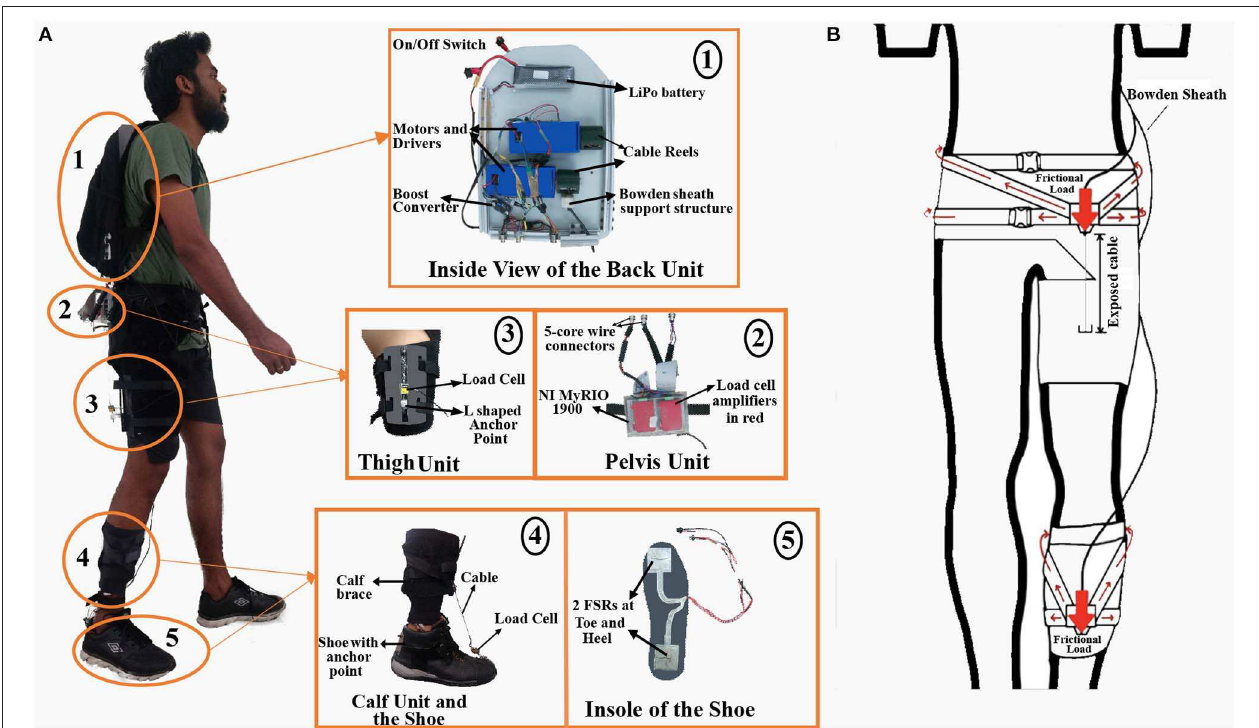
FIGURE 1 | (A) Wearable Adaptive Rehabilitation Suit (WeARS). (1) Back unit with motors and other components mounted on the HDPE plate with aluminum frame. (2) Pelvis unit with micro-controller and amplifiers. (3) Thigh unit with anchored cables and a load cell in between to record the cable tension. (4) Calf unit with load cells and a shoe with anchor points for the cable. (5) Force Sensing Resistors (FSRs) are placed on shoe insoles to measure gait events while walking. (B) Frictional load distribution over the groin and calf braces is achieved using crossed nylon webbing